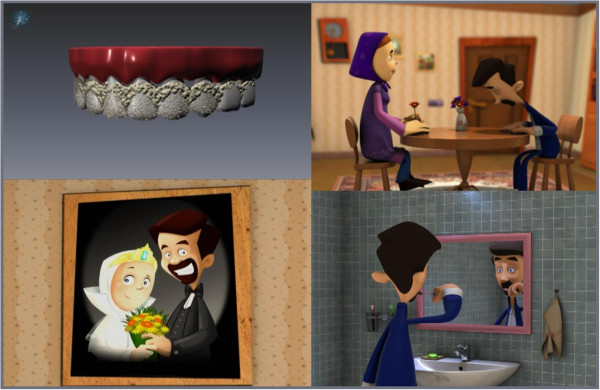
Selected pictures from the campaign.